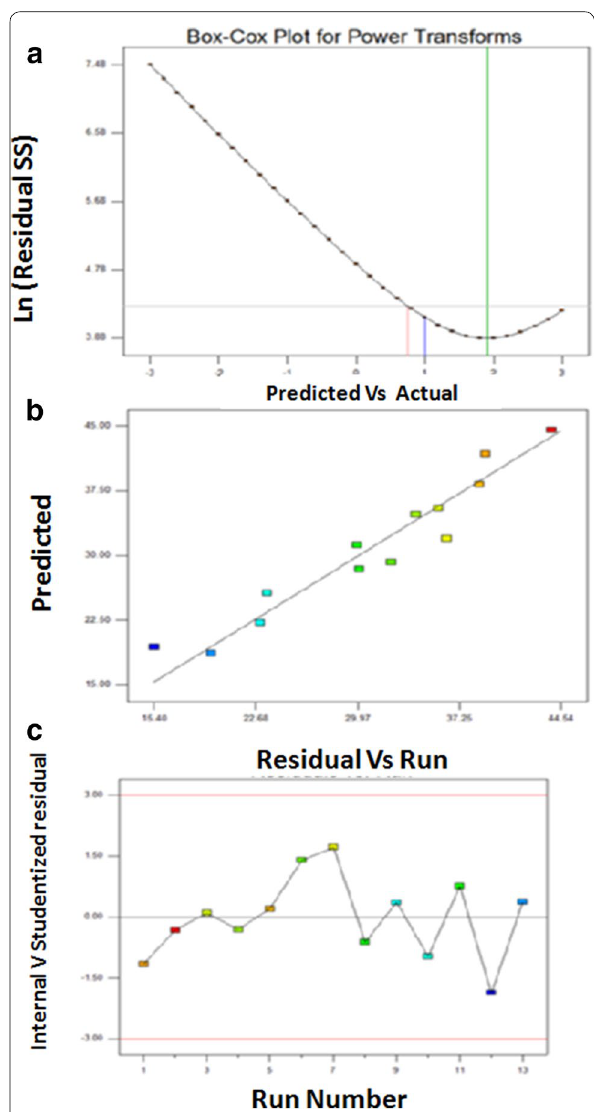
Fig. 5 Diagnostic plots for the effects of temperature, inoculum size and pH on RL production by P. aeruginosa 15GR using SSF (obtained from Design Expert software) a Box–Cox plot. b Predicted vs. actual plot. c Residuals vs. run